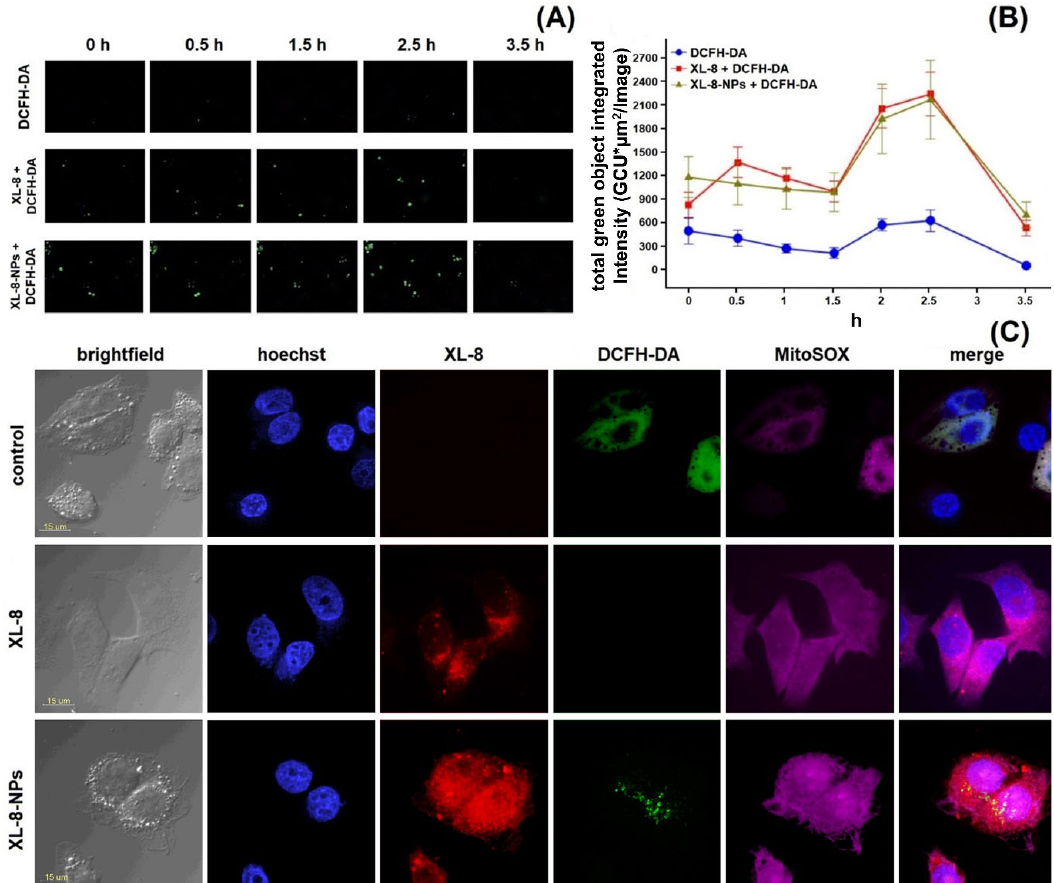
Figure 5. ROS formation kinetics in HeLa cells. Control cells were stained with DCFH-DA and irradiated. Two identical plates were treated and irradiated with XL-8 (100 nM) and XL-8-NPs (100 nM). Images were acquired every 30 min. Captured images from IncuCyte using a × 20 objective; 200 µ m scale bars ( A ). At the end of analysis, an automatic real-time assessment was performed using IncuCyte, measured as green object integrated intensity for all cells stained green with DCFH-DA, allowing generating of graphical data ( B ). Fluorescent images of HeLa cells. Subcellular localization was investigated after treatment with XL-8 (100 nM) and XL-8-NPs (120 nM), hoechst 33,342, DCFH-DA, and MitoSox Red ( C